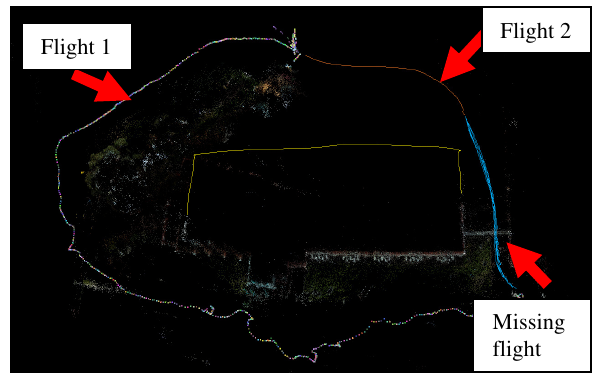
Figure 5: 3D cloud acquired from imagery (colour is taken from the imagery). All possible input data with the expected positional accuracy Figure 7: Workflow for the verification